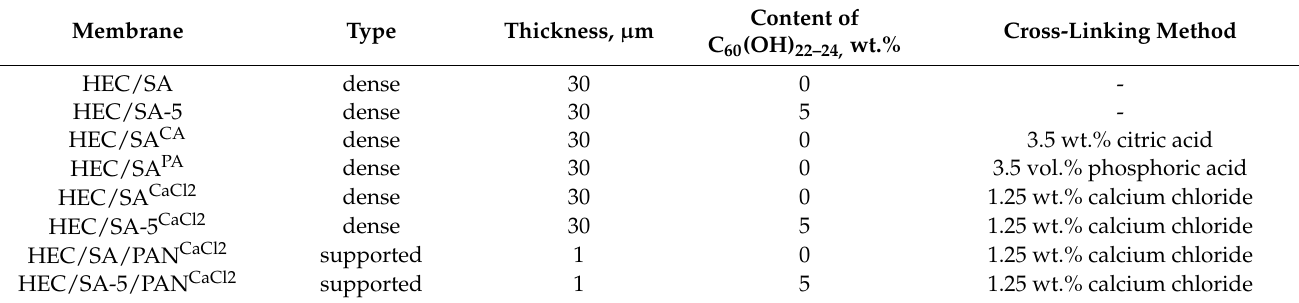
Table 2. Developed membranes based on hydroxyethyl cellulose/sodium alginate (HEC/SA) (30/70 wt.%) blend. Membrane Type Thickness, µ m